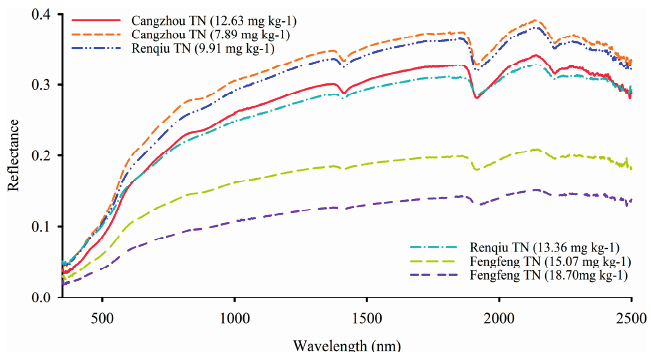
Figure 5. Original reflectance curve of soil samples with different TN